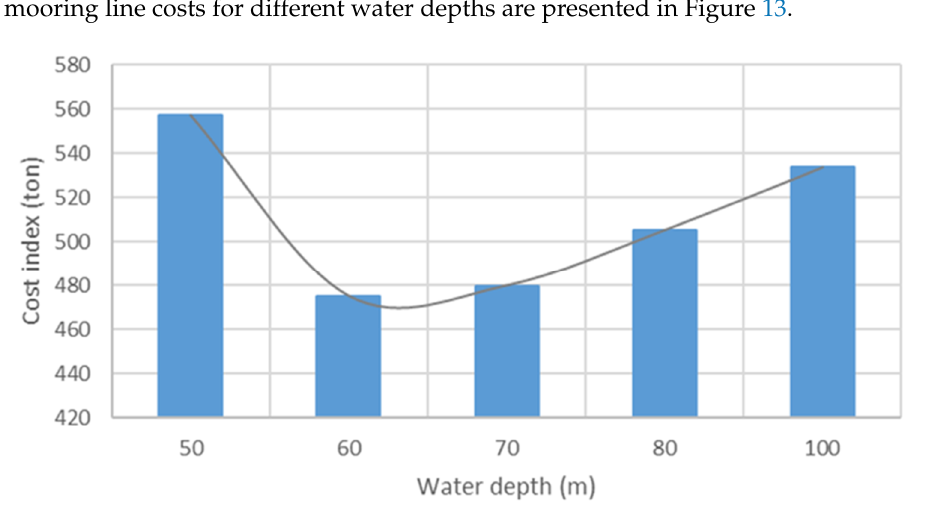
Table 10. Value of cost index of each mooring line (unit: ton).